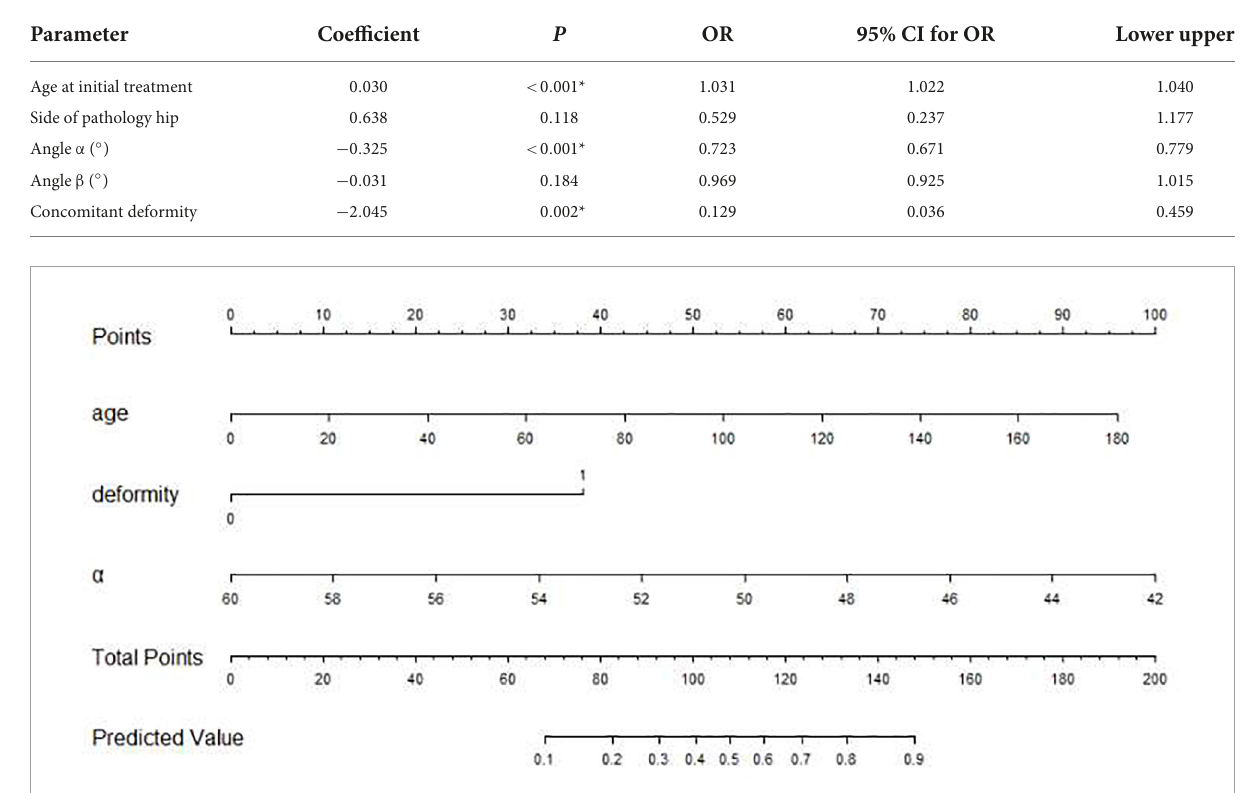
applying this online nomogram with the extent of the threshold ( Figure 5